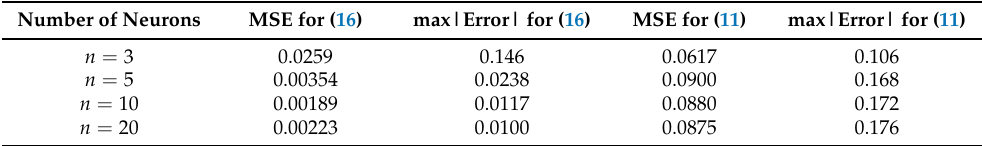
Table 1. Results of solving the implicit Equation (16). A comparison of the mean square error (MSE) and the maximum value of the absolute error for the neural network solution to Equation (16) with basis functions (18) and the corresponding solution of the problem (11) for different numbers of neurons per a hidden